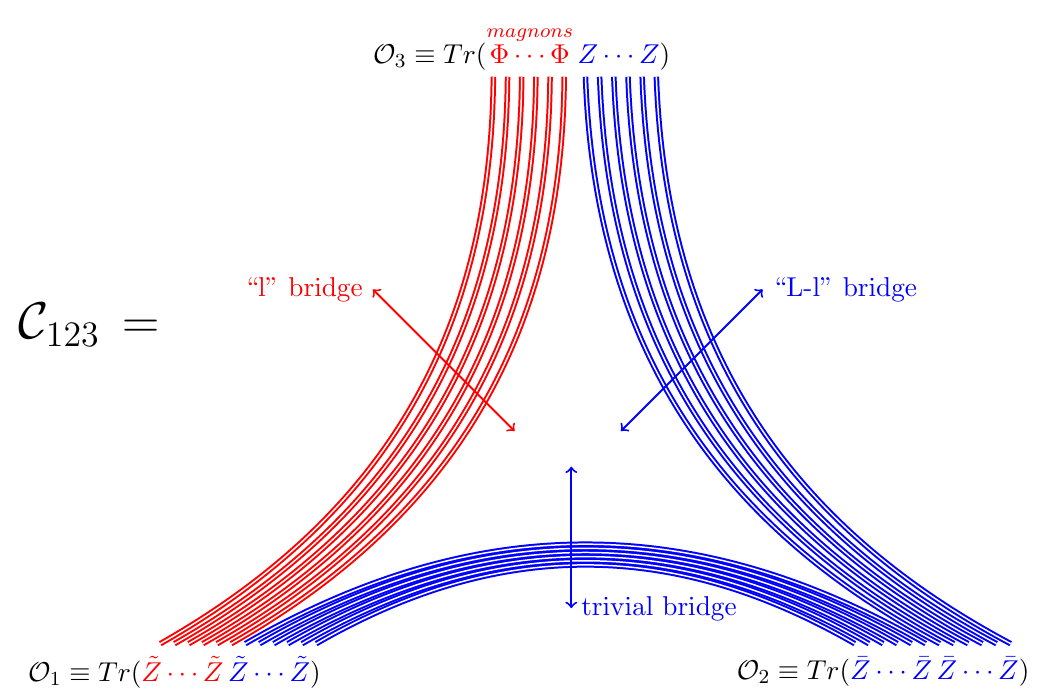
Figure 8. Wick contraction for planar tree level structure constant